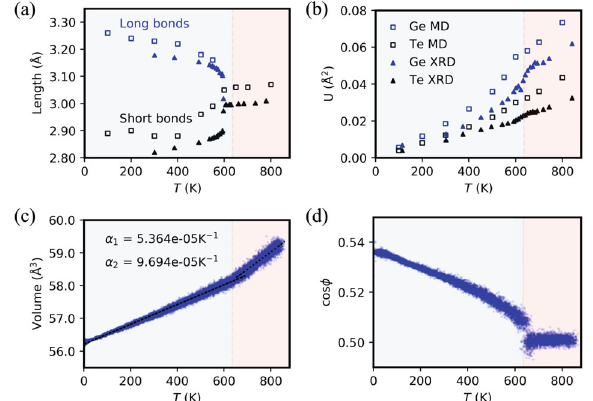
Fig. 2 Temperature dependence of the structural parameters. (a) Bond lengths of GeTe at different temperatures were obtained from MD simulations with the NVT ensemble (open square) and neutron diffraction measurements (solid triangle) 11 . ( b) ADPs at different temperatures obtained from MD simulations with the NVT ensemble (open square) and X-ray powder diffraction measurements (solid triangle) 21 . ( c) The primitive cell volume and ( d ) the rhombohedral angle of GeTe as a function of temperature obtained from MD simulation with the NPT ensemble at a heating rate of 450 K per ns. The light blue and red shaded areas represent α -GeTe and β -GeTe phases, respectively, based on our MD results.